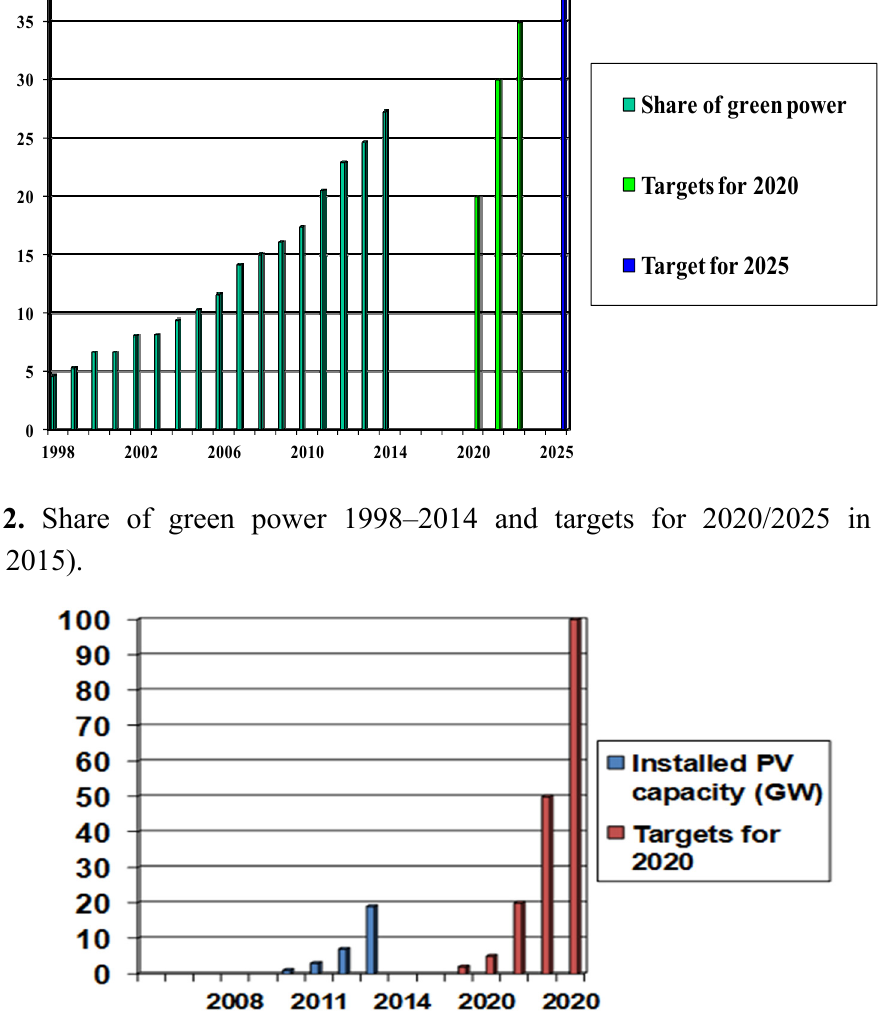
Figure 3. Installed PV capacity in China and targets for 2020 (Data basis REN21